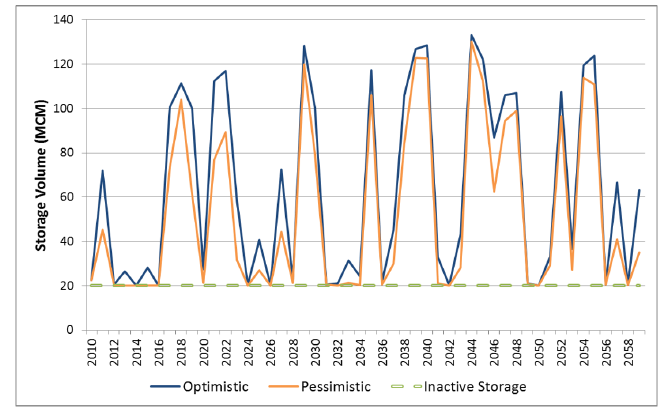
Figure 5. Quiroz-Chipillico watershed model’s storage volume in the San Lorenzo reservoir.